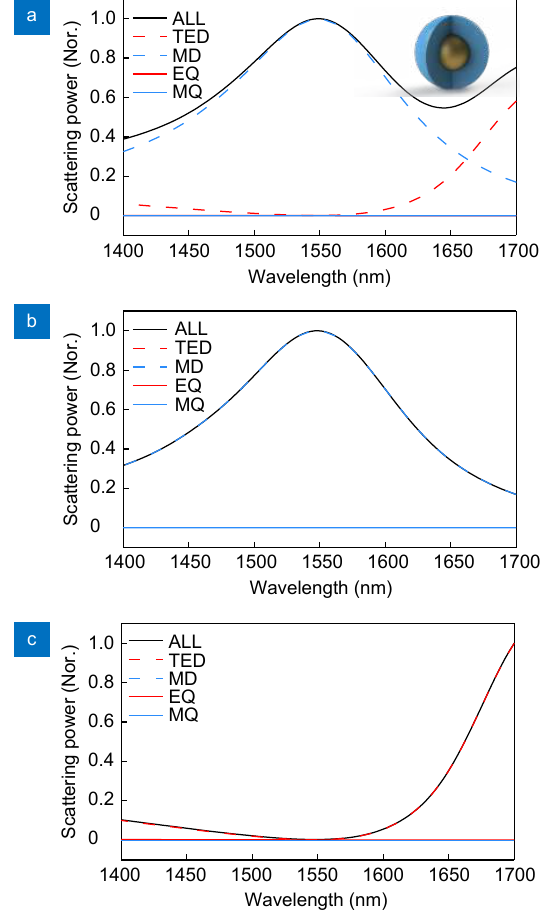
Fig. 2 | Numerical results of electromagnetic multipolar decomposi- tion for the normalized scattering power of a Au core/Si shell nano- particle under the excitation by ( a ) a plane wave, ( b ) a tightly fo- cused AP beam and ( c ) a tightly focused RP beam. The radius of Au core is 86 nm while the outer radius of Si shell is 226 nm. The NA and magnification factor of the objective lens are 0.95 and 60, re- spectively. TED represents the contribution of toroidal and electric di- pole to total